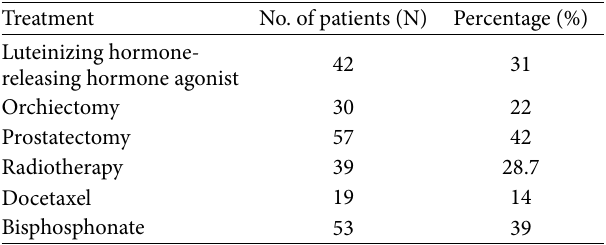
Note: Some patients received more than one